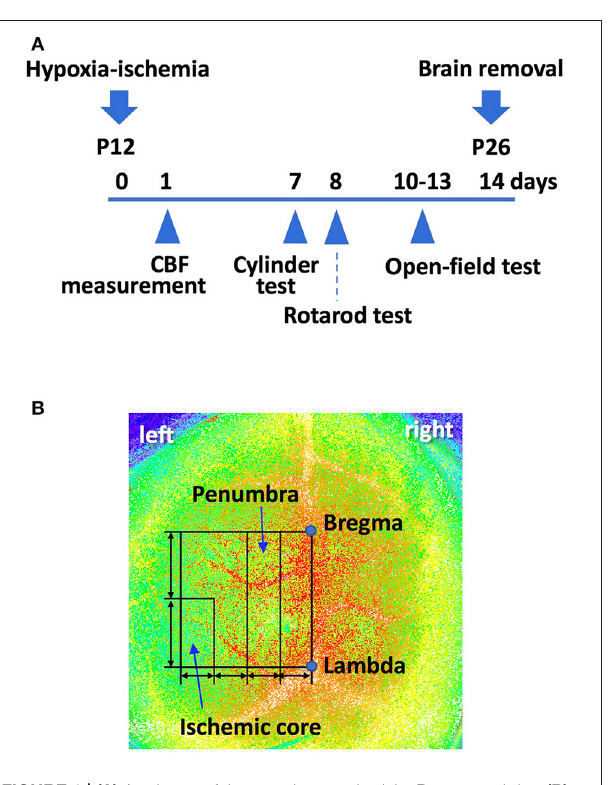
FIGURE 1 | (A) A scheme of the experiment schedule. P; postnatal day. (B) Using laser speckle flowmetry, we measured cerebral blood flow (CBF) in the “penumbra” and “ischemic core” regions, both of which were set as shown, at 24h after the surgery. A line was drawn from bregma to lambda. This line was used to draw a square. The line perpendicular to the bregma-lambda line was divided into four equal segments. The second quarter-rectangle from the center was defined as the “penumbra” region. The posterior half of the most lateral segment was defined as the “ischemic core” region. We also measured CBF in the corresponding region of the contralateral